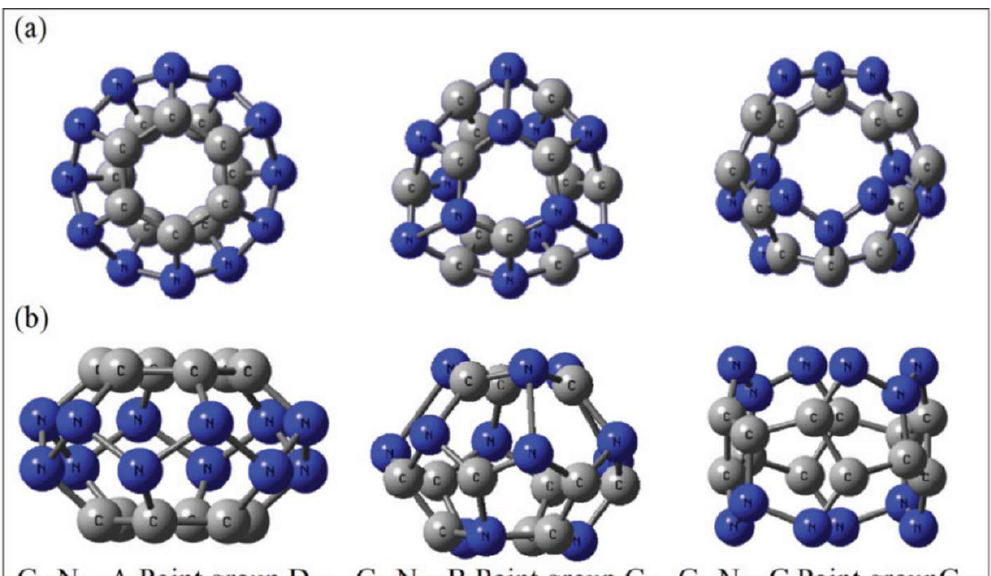
Figure 8. Local minima form of C 12 N 12 -A, C 12 N 12 -B and C 12 N 12 -C. In ( a ) panel, the top view is pro- vided, whereas in panel ( b ), the side view is shown. This figure is reproduced from Reference [21].